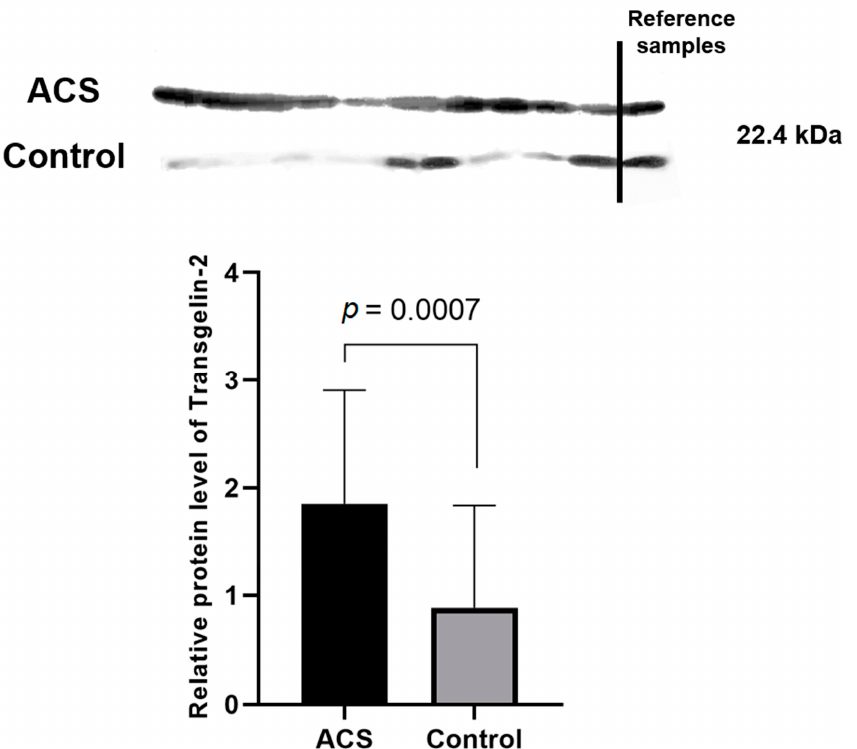
Figure 5. Expression of transgelin-2 protein in blood platelets of ACS patients and control subjects. The integrated optical density (IOD) was analyzed by densitometry and normalized by the protein concentration and reference sample. The graph demonstrates the median value from IODs with an interquartile range (25%–75%). Data were calculated using the Mann–Whitney U test.